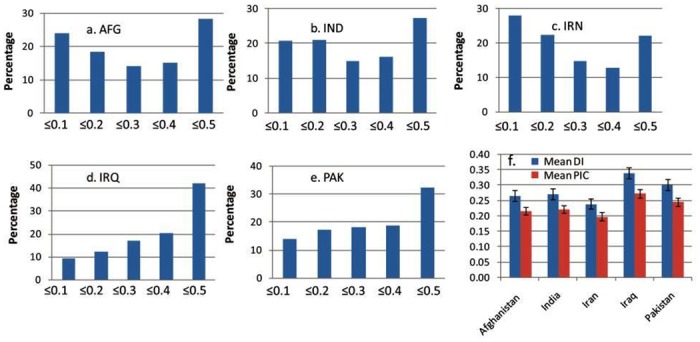
Nei’s diversity index (DI) distribution across Afghanistan (a), India (b), Iran (c), Iraq (d) and Pakistan (e).Each column in a-e represents percentage of markers having DI either equal to or less than the value shown on X-axis. Part f of figure represents mean DI and PIC across all countries.